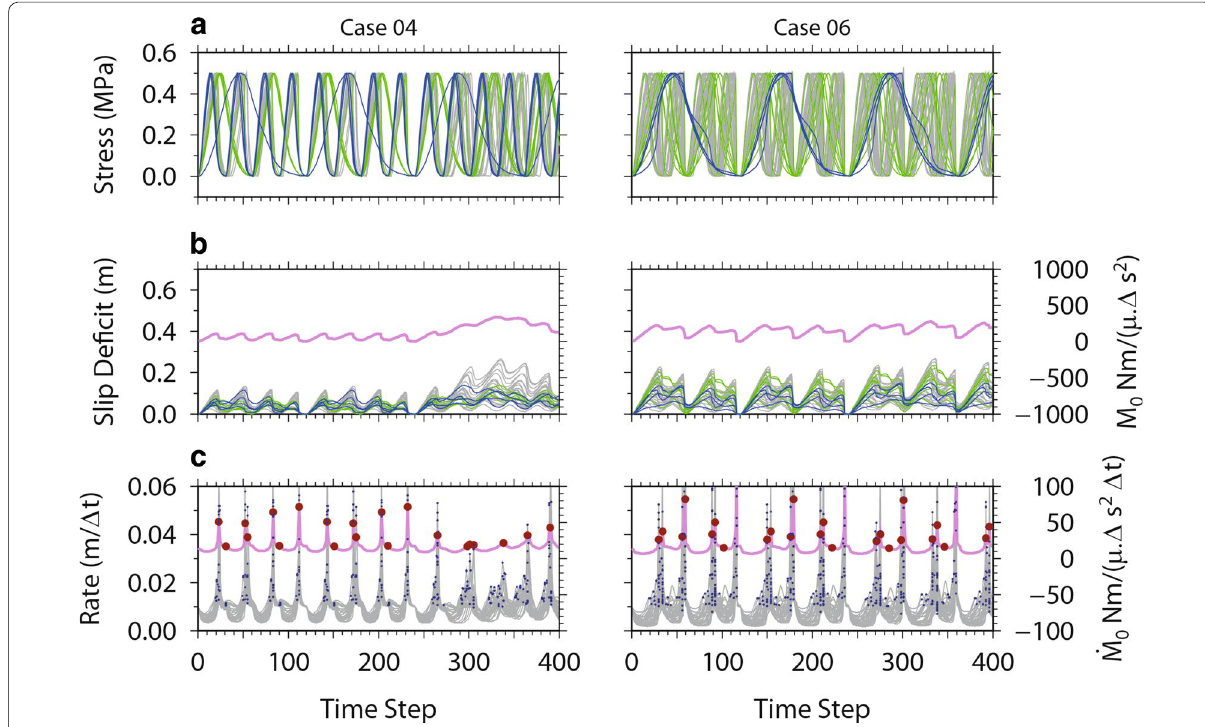
Fig. 11 Temporal evolution of the simulations for cases (4) and (6), with the same parameters settings as shown in Fig. 7, except that w 0 = 0 . a Shear stress evolution at the center of each patch. The colors correspond to the order of patches, with blue , green , and gray for k = 2,3,and 4 , respectively. b Average slip deficit for each patch. M 0 is shown with a pink curve. c Average slip rate for each patch. ˙ M 0 is shown with a pink curve . The local peaks of each curve are identified by red points according to the change in sign of the